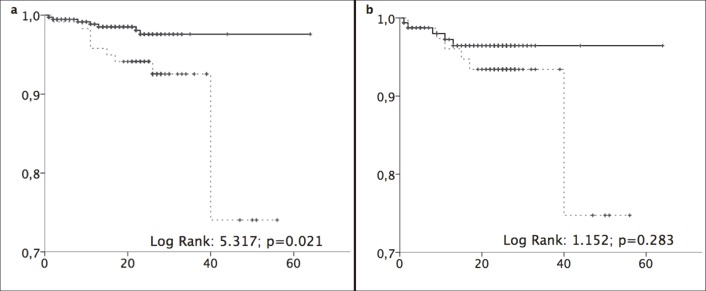
All-cause mortality.(a) All-cause mortality. (b) All-cause mortality in stage F4 patients. Kaplan–Meier curves were compared using log-rank tests between patients aged ≥65 years (black lines) and <65 years (grey dotted lines). Abscissa: time in months. Ordinate: cumulative survival.